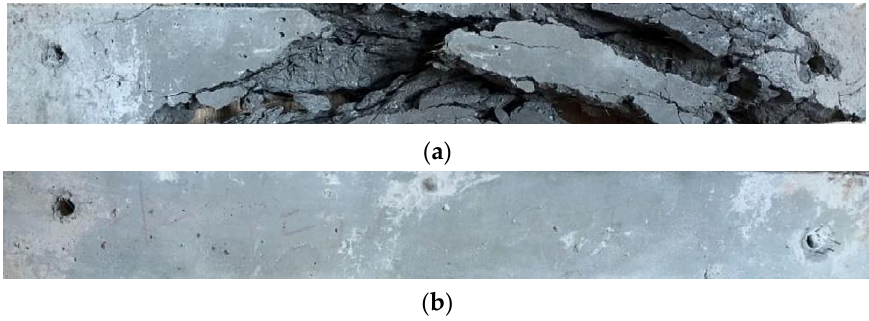
Figure 3. The influence of high temperatures on ( a ) concrete; ( b ) PE-ECC [79].